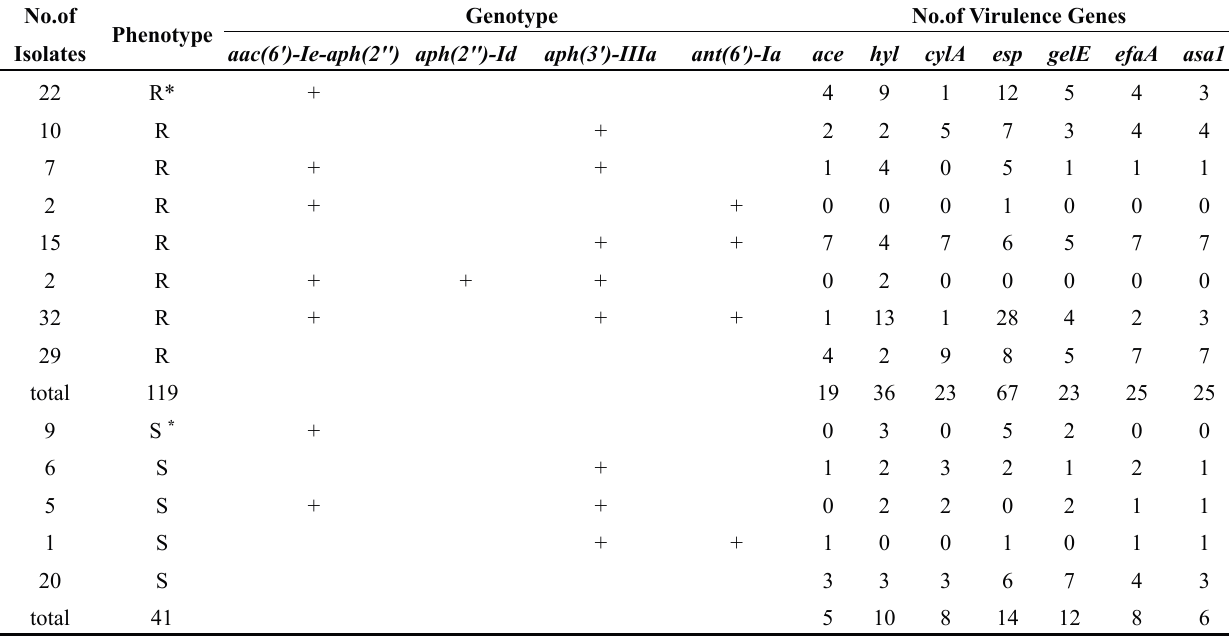
Table 3. Frequency of different virulence genes in Enterococcus